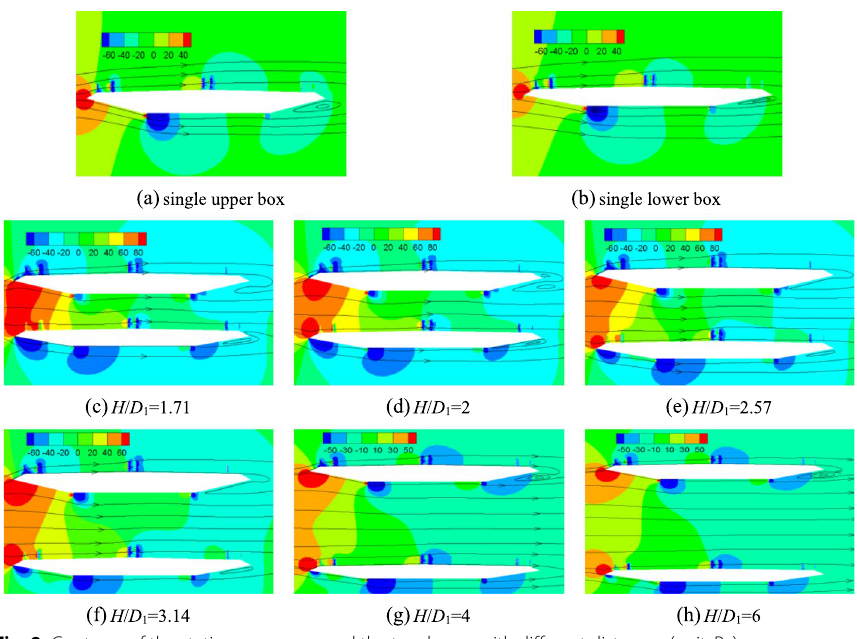
Fig. 9 Contours of the static pressure around the two boxes with different distances (unit: Pa)